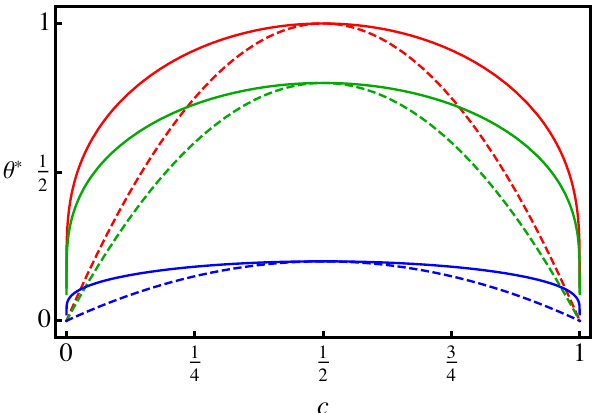
Figure 1. Linear chemoelastic binodal θ ∗ leb ( c , 3 υ S ) (solid curves) and spinodal θ ∗ les ( c ) (dashed curves) 2 for a solute misfit of υ S = 0 (red), υ S = 0.02 (green), υ S = 0.04 (blue), with v m k el / w AB = 10 3 .